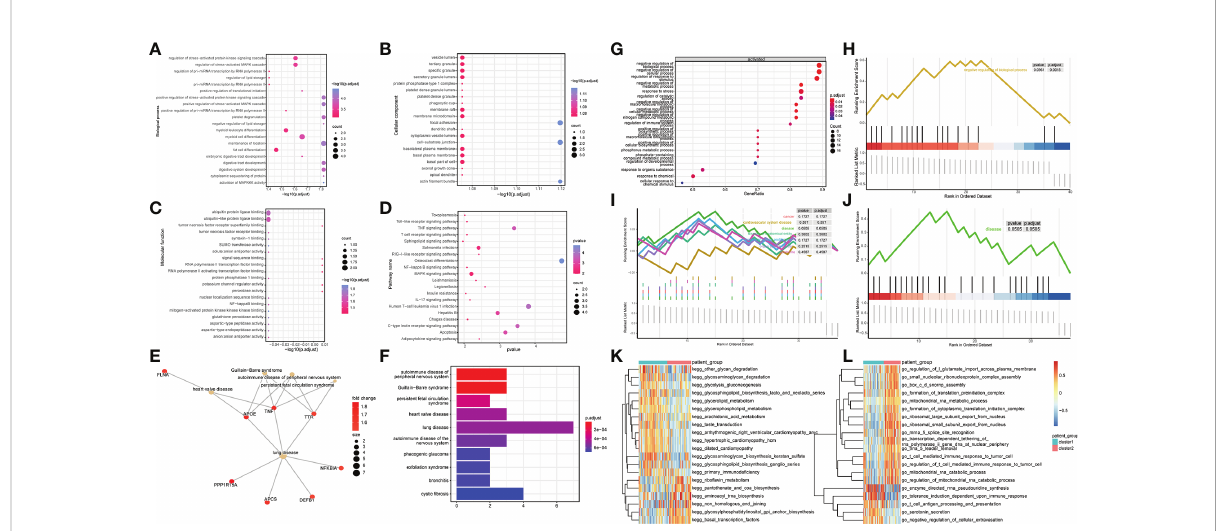
FIGURE 4 DEGs identi fi cation and functional enrichment analysis between samples. (A-C) GO enrichment analysis was performed on up-regulated, and down-regulated genes, and biological process (BP), molecular function (MF), and cellular component (CC) were displayed. Node size indicates the number of genes enriched in the pathway, and node color indicates -log10 (p-value). (D) Results of KEGG pathway analysis, the node size represents the number of genes enriched in the pathway, and the node color represents the p-value. (E, F) DOSE enrichment results. (G) Overall Gene Ontology enrichment analysis results. (H) gsea-go enrichment pathway analysis results. (I, J) The overall and partial gsea_dose enrichment results are displayed. (K, L) GSVA enrichment